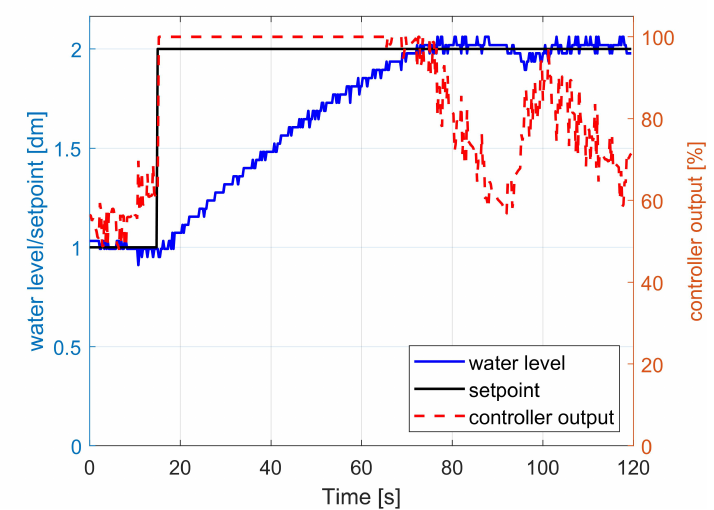
Figure 14. Control system response of optimized DPID realization by PLC; sampling time equals 0.15